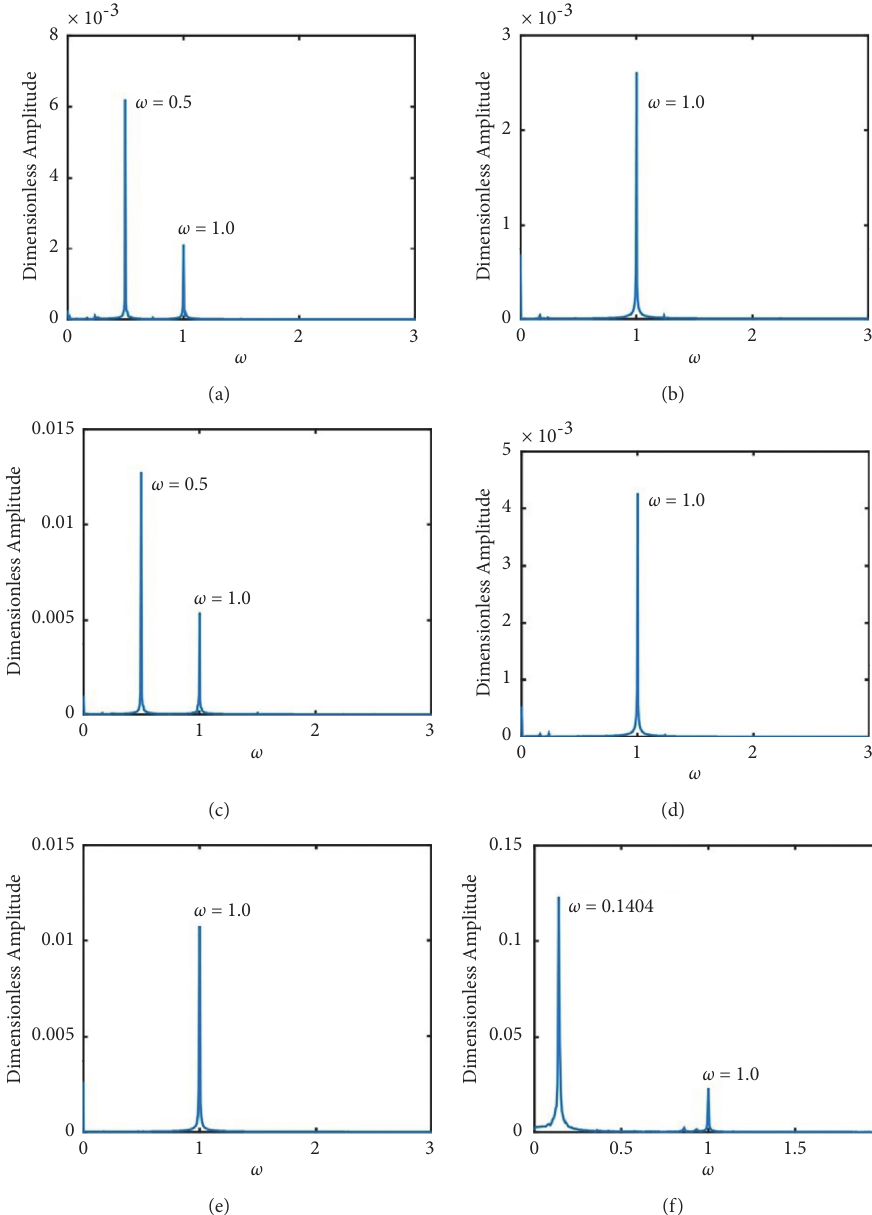
Figure 10: Spectrums of the responses at (a) λ � 5 . 6 (run-up), (b) λ � 5 . 6 (run-down), (c) λ � 5 . 85 (run-up), (d) λ � 5 . 85 (run-down), (e) λ � 5 . 69, and (f) λ � 6 . 48 when N b �